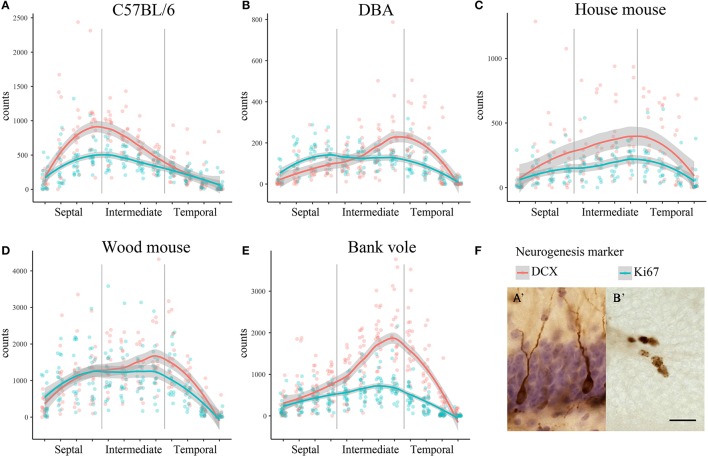
Distribution of neurogenesis-related absolute cell counts along the septo-temporal axis. Neurogenesis assessment in dissected, straightened hippocampi in laboratory C57BL/6 (A) follows a general septal>temporal gradient, whereas DBA (B), house mice (C), wood mice (D), and bank voles (E) show a septal<temporal gradient for young neurons (DCX), and, except for DBA, also for cell proliferation (Ki67). Raw data of cell counts were re-distributed into 12 virtual sections to allow direct comparisons within and between species/strains, gray areas indicate 95% confidence intervals. (F) Shows representative images of hematoxylin-counterstained DCX+ young neurons (A') and Ki67+ cells (B') in the subgranular layer of the dentate gyrus. Scale bar = 20 μm.